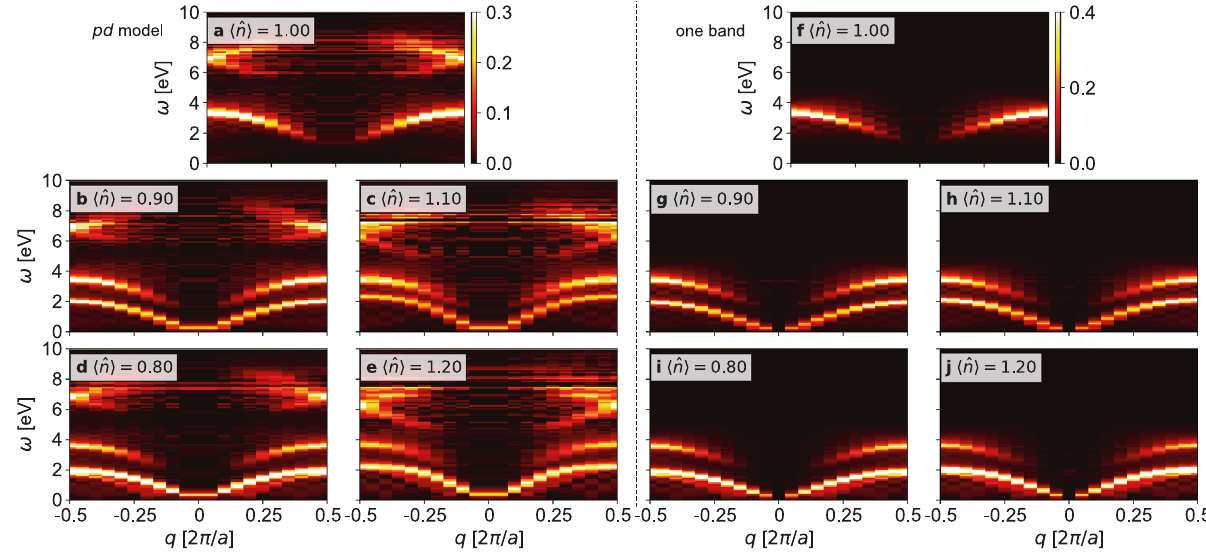
Fig. 8 Zero temperature density matrix renormalization group (DMRG) method results for the total dynamical charge structure factor N ( q , ω ) of the multi-orbital pd - and single-band Hubbard models. Panels a − e show the dynamical charge structure factor N ( q , ω ) as a function of momentum q and energy ω , obtained from DMRG simulations of the multi-orbital with a Cu − O basis (the pd -model) at various fi llings h ^ n i , as indicated. Panels f − j show corresponding results for DMRG simulations of the single-band Hubbard model. Both sets of results were obtained using chains with N = 20 unit cells. The model parameters are identical to those used in Fig.